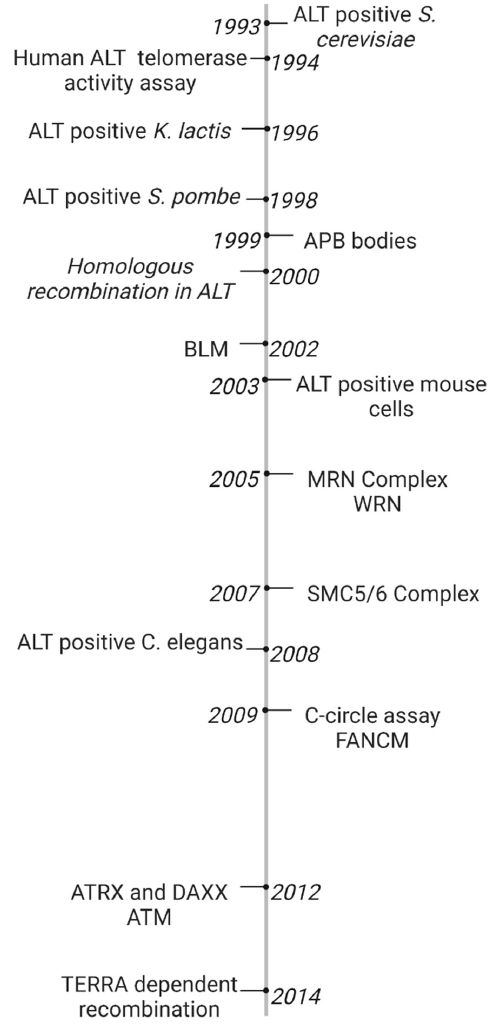
Figure 1. Timeline of ALT Discoveries. The ALT pathway was fi rst identi fi ed in S. Cerevisiae [26].